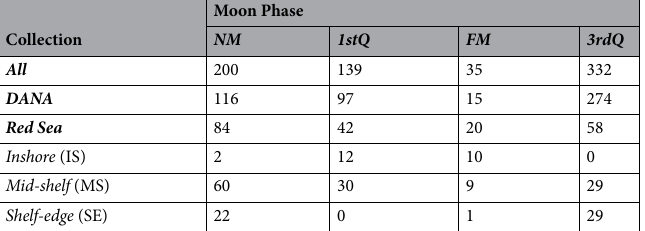
Table 1. Total abundances of adult LDF Schindleria (All) observed in each of the four main moon phases: the new moon (NM), the 1st quarter moon (1stQ), the full moon (FM), and the 3rd quarter moon (3rdQ) comprising two different data sets: The Red Sea collections (at an inshore (IS: 22.3055° N, 39.0493° E), a mid- shelf (MS: 22.3054° N, 38.9684° E), and a shelf-edge (SE: 22.3415° N, 38.8538° E) reef) and the collection from the DANA Expedition from 1928–1930 (DANA) 12 .